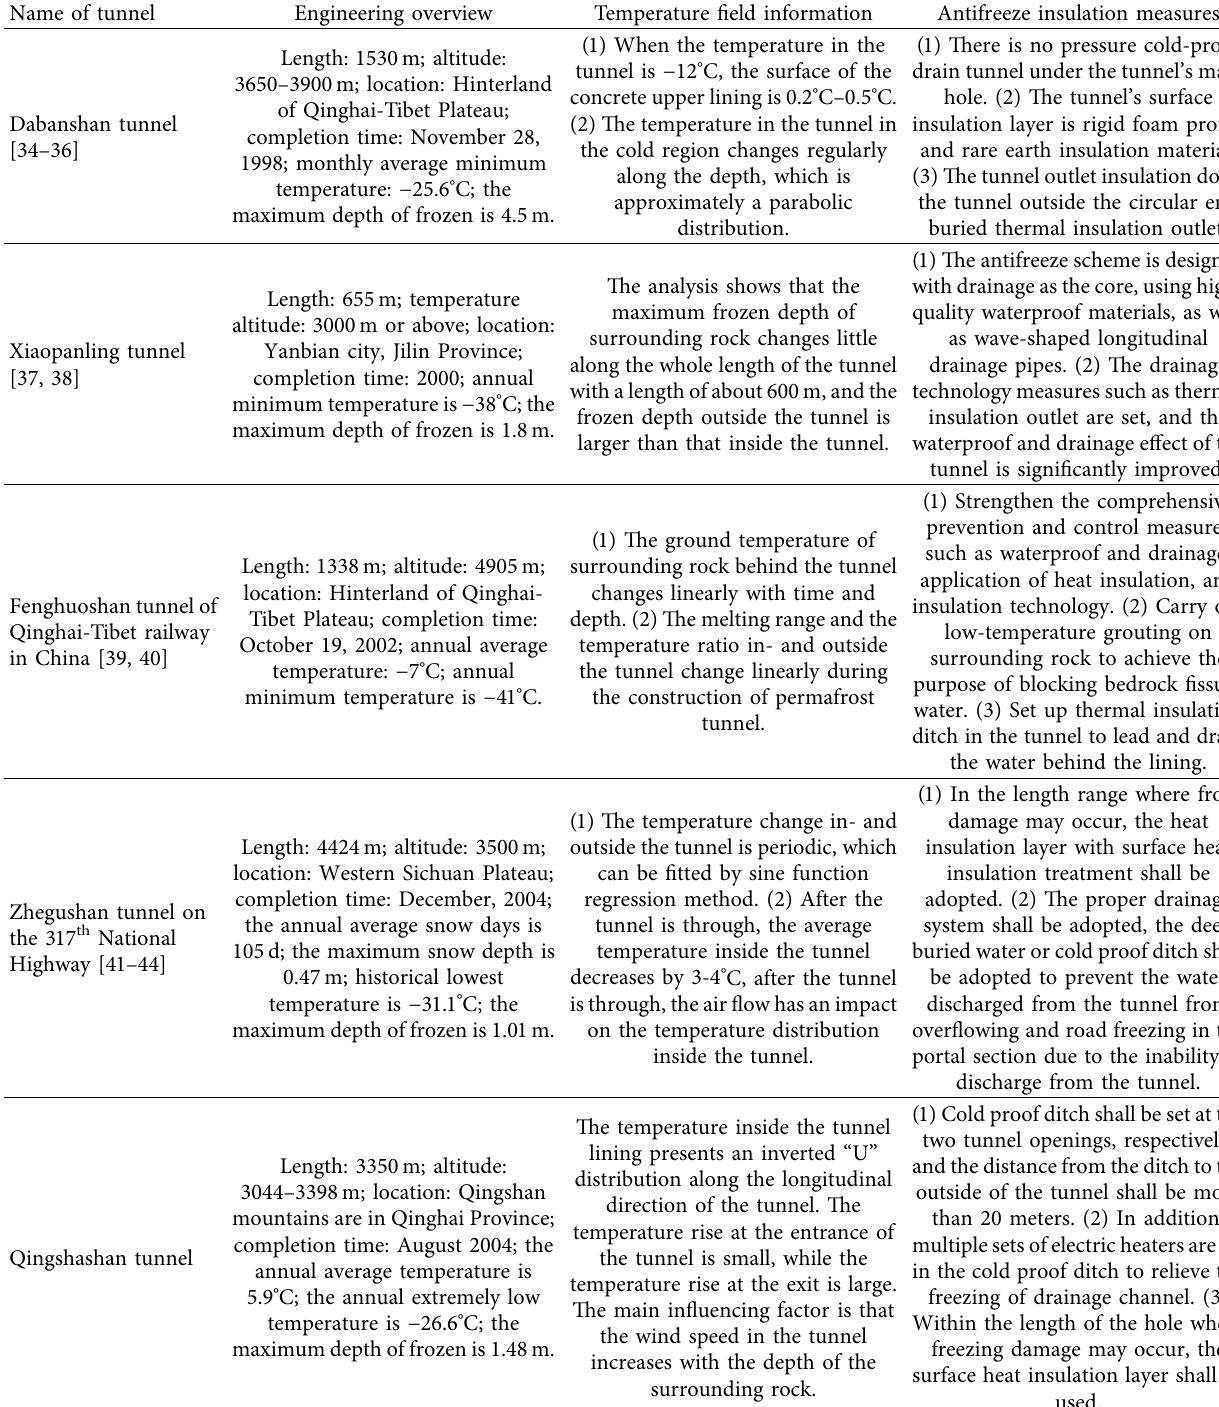
Table 5: Construction experience of similar tunnel